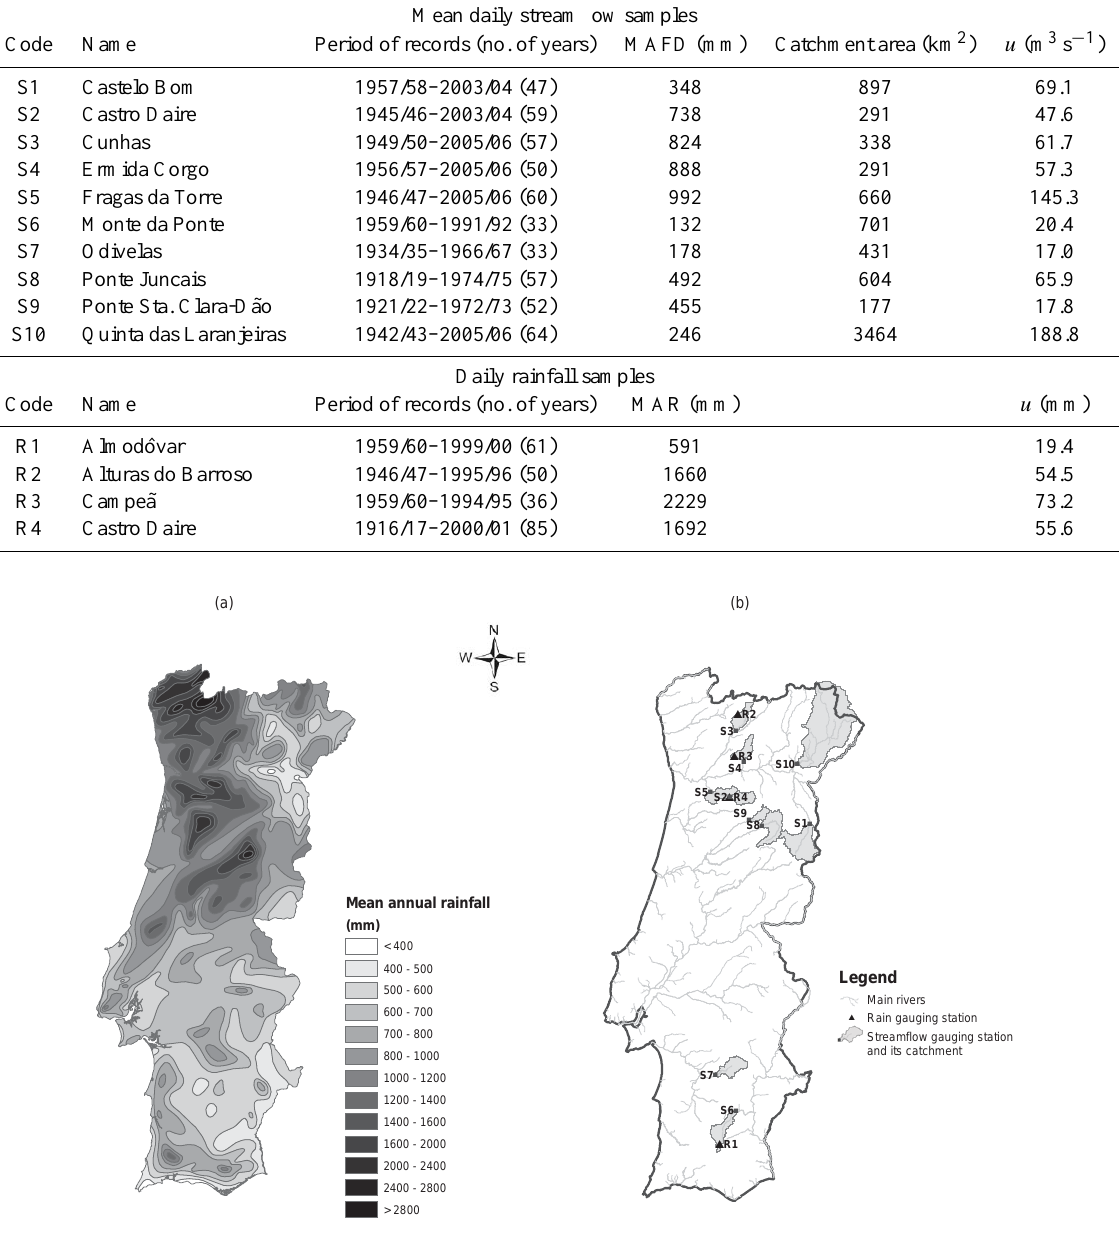
Table 1. Mean daily streamflow and daily rainfall data. Sample code, name and periods of records of the samples; mean annual flow depth, MAFD (mm), and area of the catchments; mean annual rainfall, MAR (mm); POT sampling threshold values, u (m 3 s − 1 and mm, respectively).